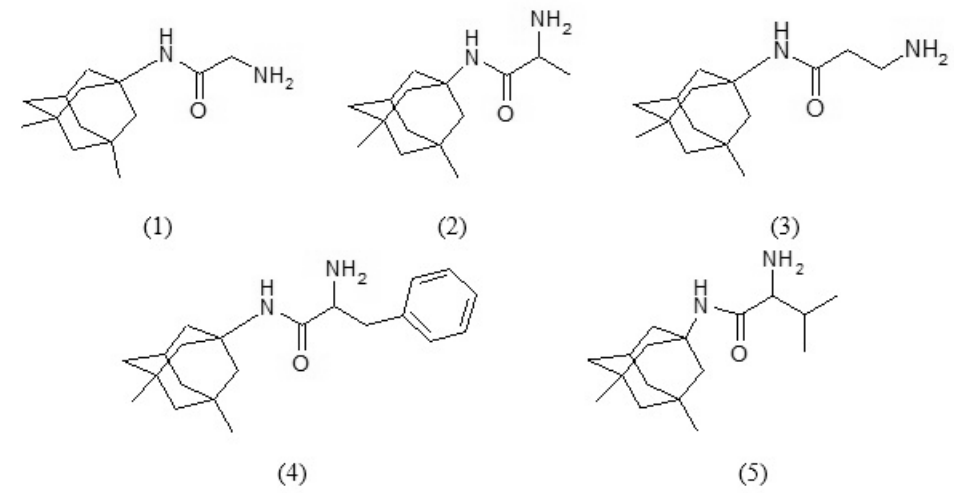
Figure 1. Memantine analogues with amino acids: alanyl-memantine Ala-MEM (1), β -alanyl- memantine β Ala-MEM (2), glycyl-memantine Gly-MEM (3), phenylalanyl-memantine Phe-MEM (4) and valyl-memantine Val-MEM (5).